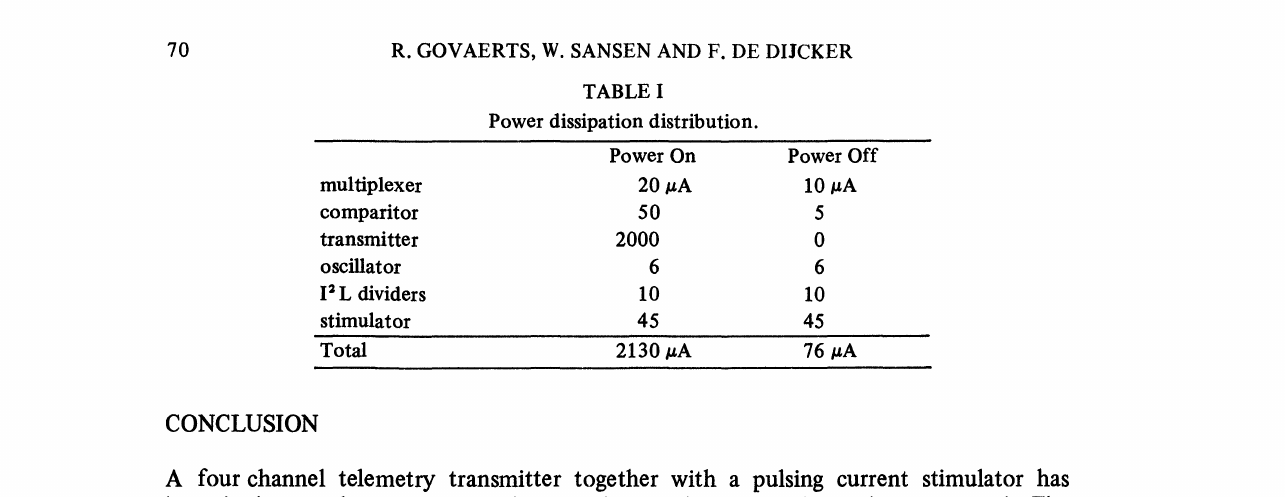
Power dissipation